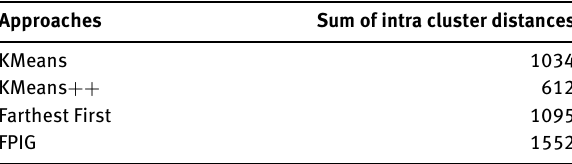
Table 6: Sum of Intracluster Distances Between Analyzed